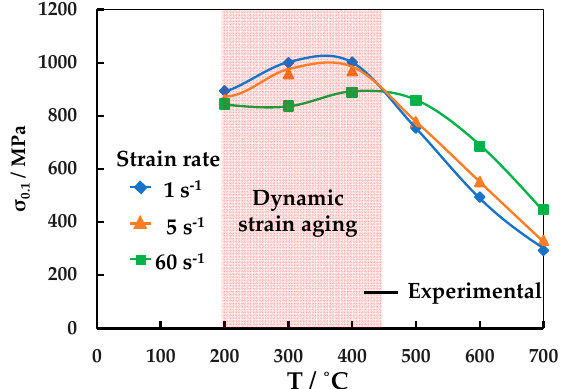
Figure 4. Flow stress at a true plastic strain of 0.1 versus temperature.